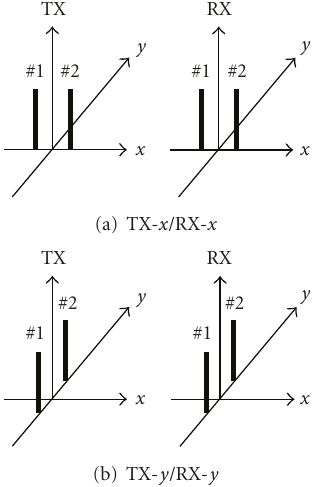
Figure 3: Antenna array orientations.